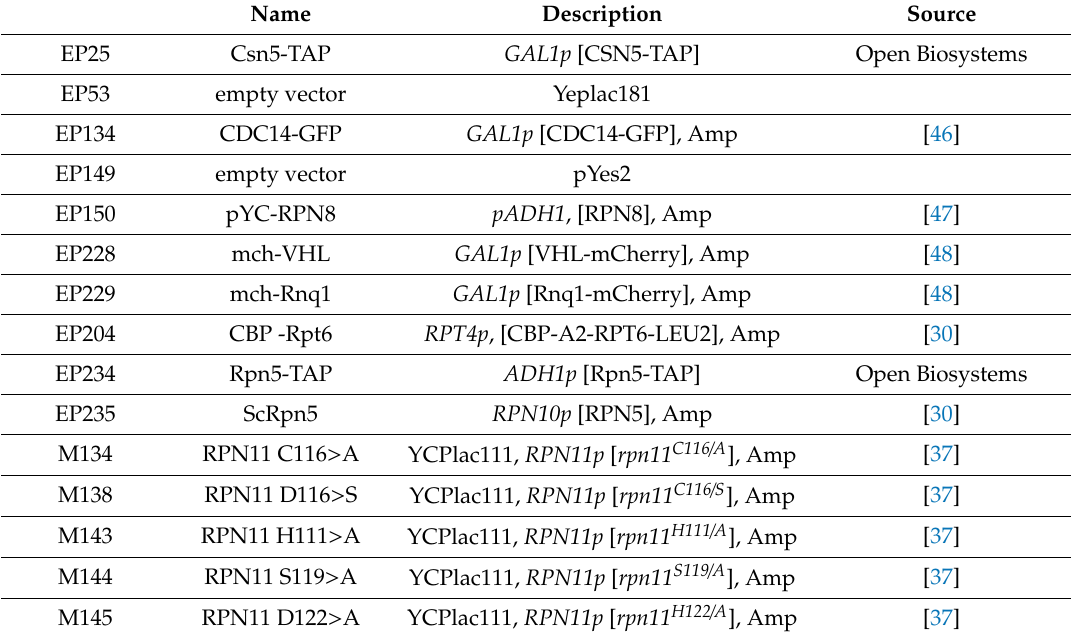
Table 1. Plasmids used in this study.